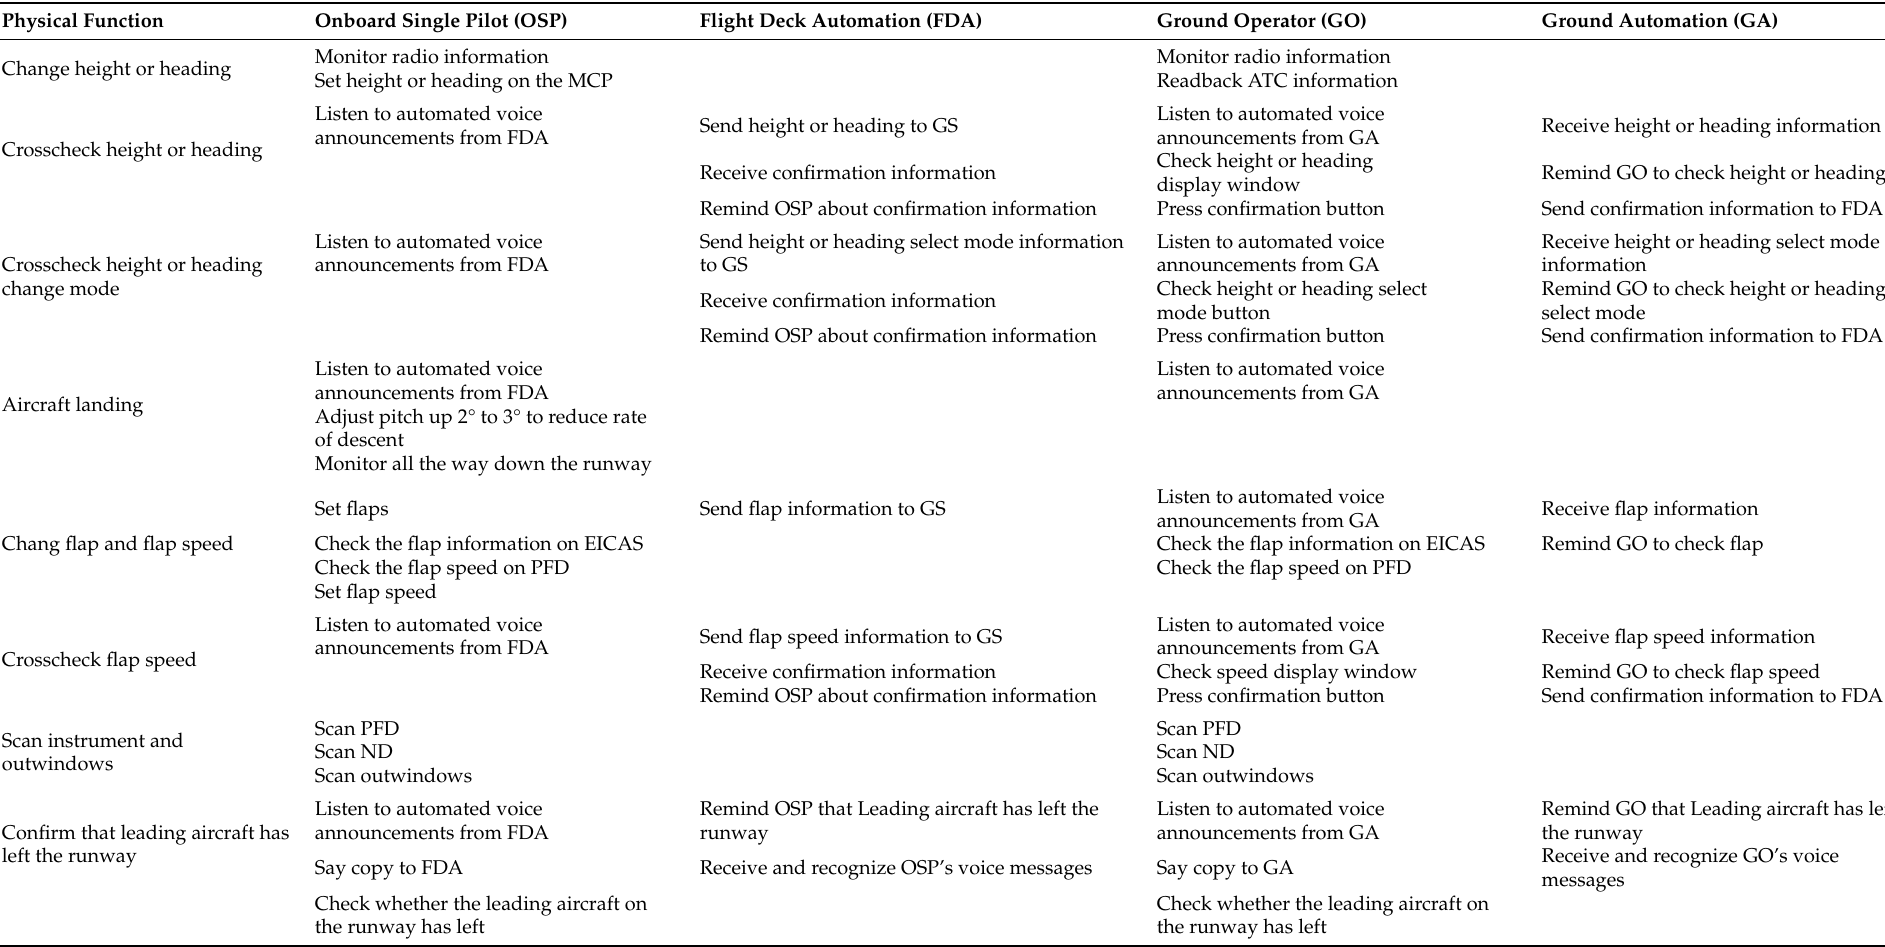
Table 2. Functions performed by the Onboard Single Pilot (OSP), Flight Deck Automation (FDA), Ground Operator (GO) and Ground Automation (GA) in the single pilot